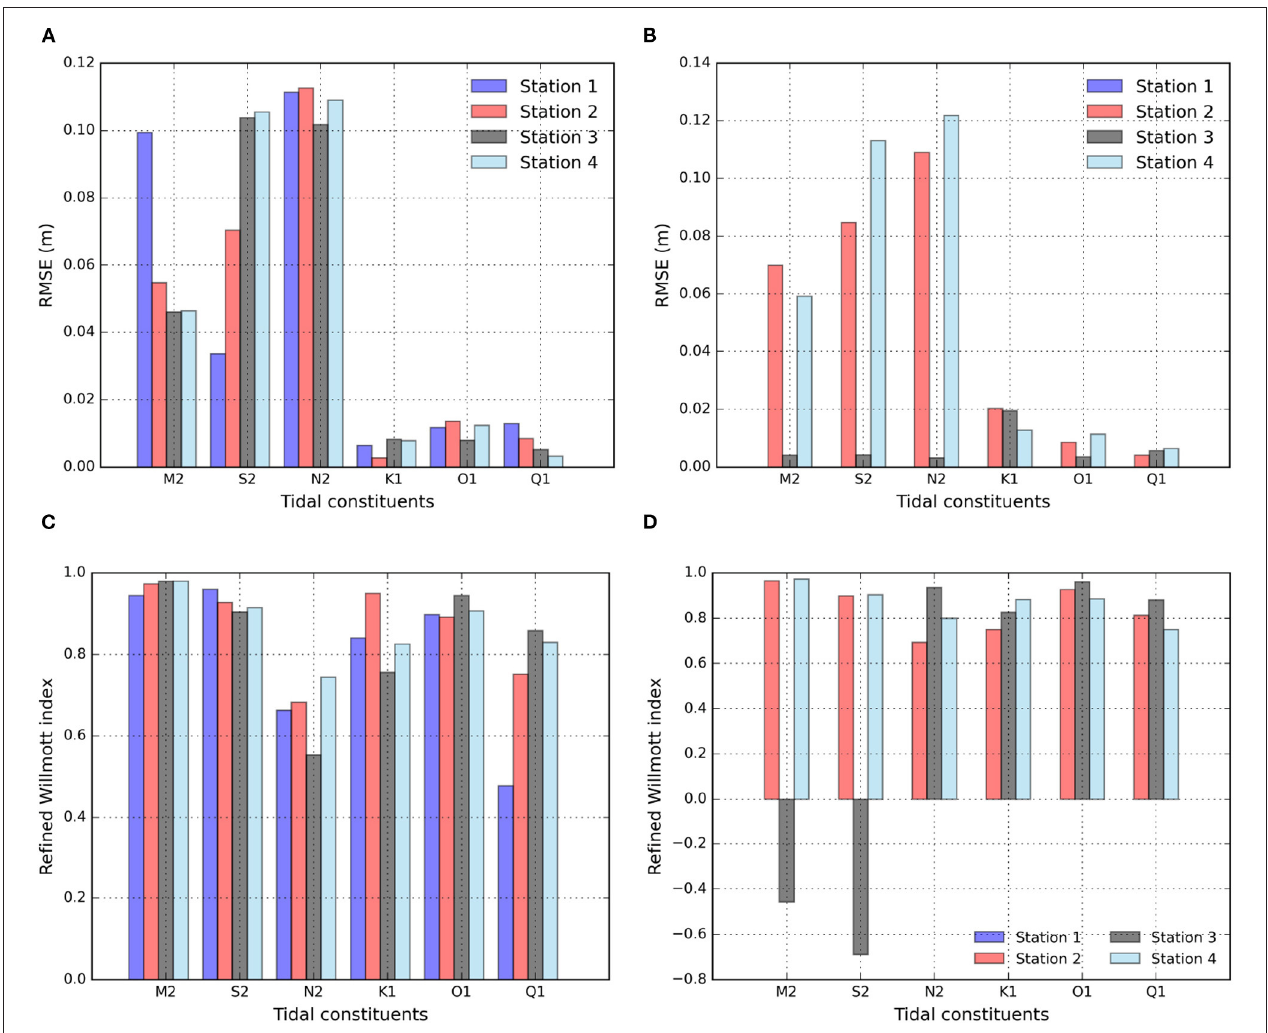
FIGURE 5 | RMSE in March (A) and in August (B) ; and the refined Willmott index in March (C) and in August (D) between the modeled and observed Sea Surface Height anomaly for each station (detailed in Table 1 ) and M2, S2, N2, K1, O1, and Q1 tidal